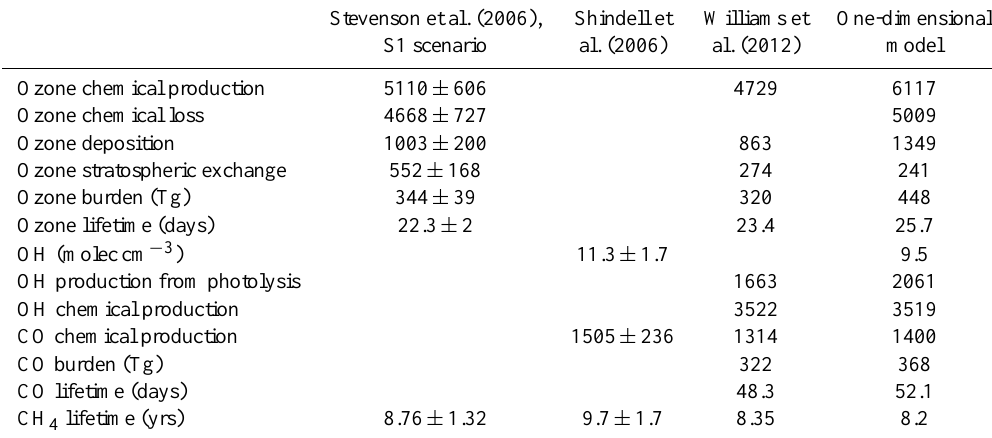
Fig. 2. Vertical profiles of ozone, NO x , CO, and CH 4 obtained with the one dimensional model for the years 1890 and 1990. Table 4. Comparison of trace gas budgets for the global troposphere obtained with our one-dimensional model, with the results from other models. Numbers in Tgyr − 1 , unless otherwise specified. Stevenson et al. (2006), Shindell et Williams